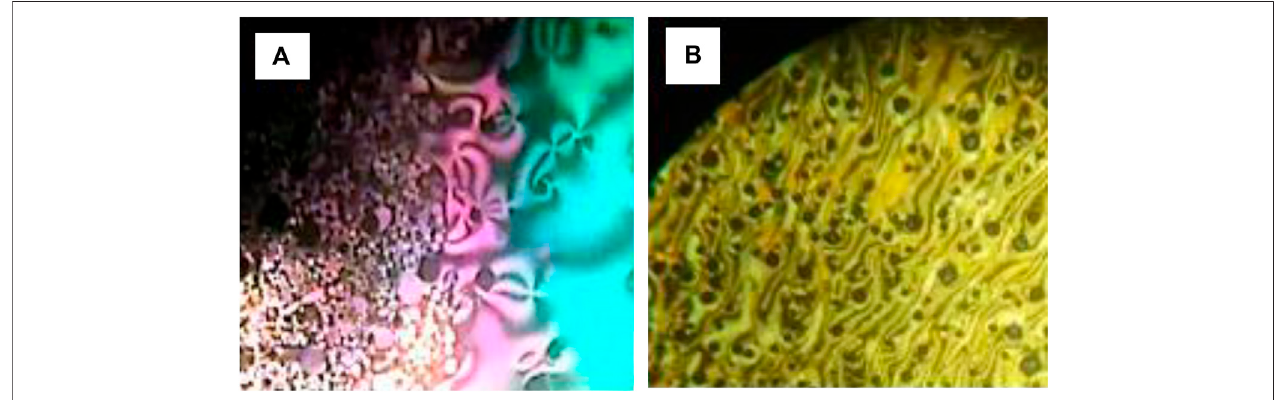
FIGURE 5 | Nematic phase textures upon heating observed under POM for compounds (A) A6 at 155.0 ° C and (B) A10 at 115.0 ° C.